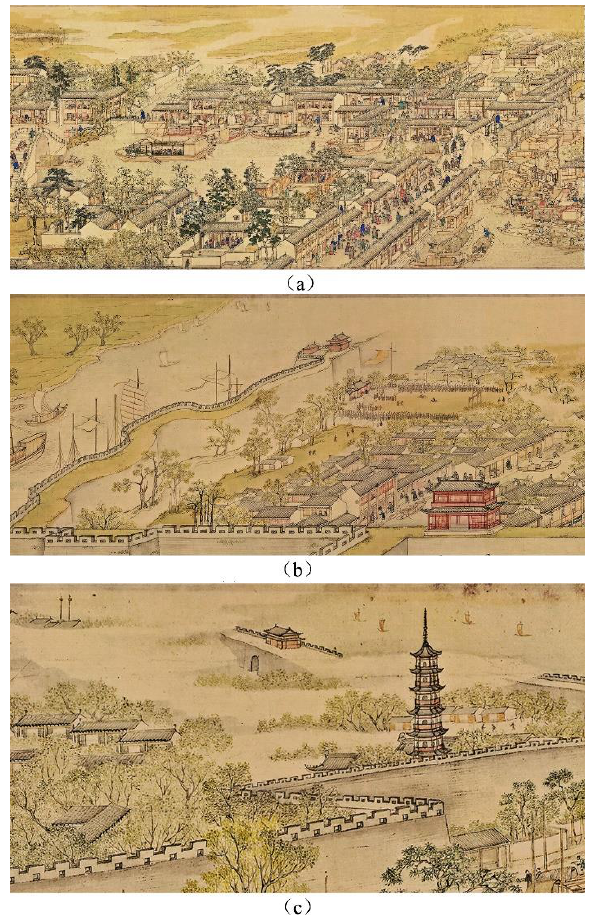
Figure 7. Three sections of The Scroll of the Flourishing Times. ( a ) Shantang Street. ( b ) the North Field. ( c ) the South Field.